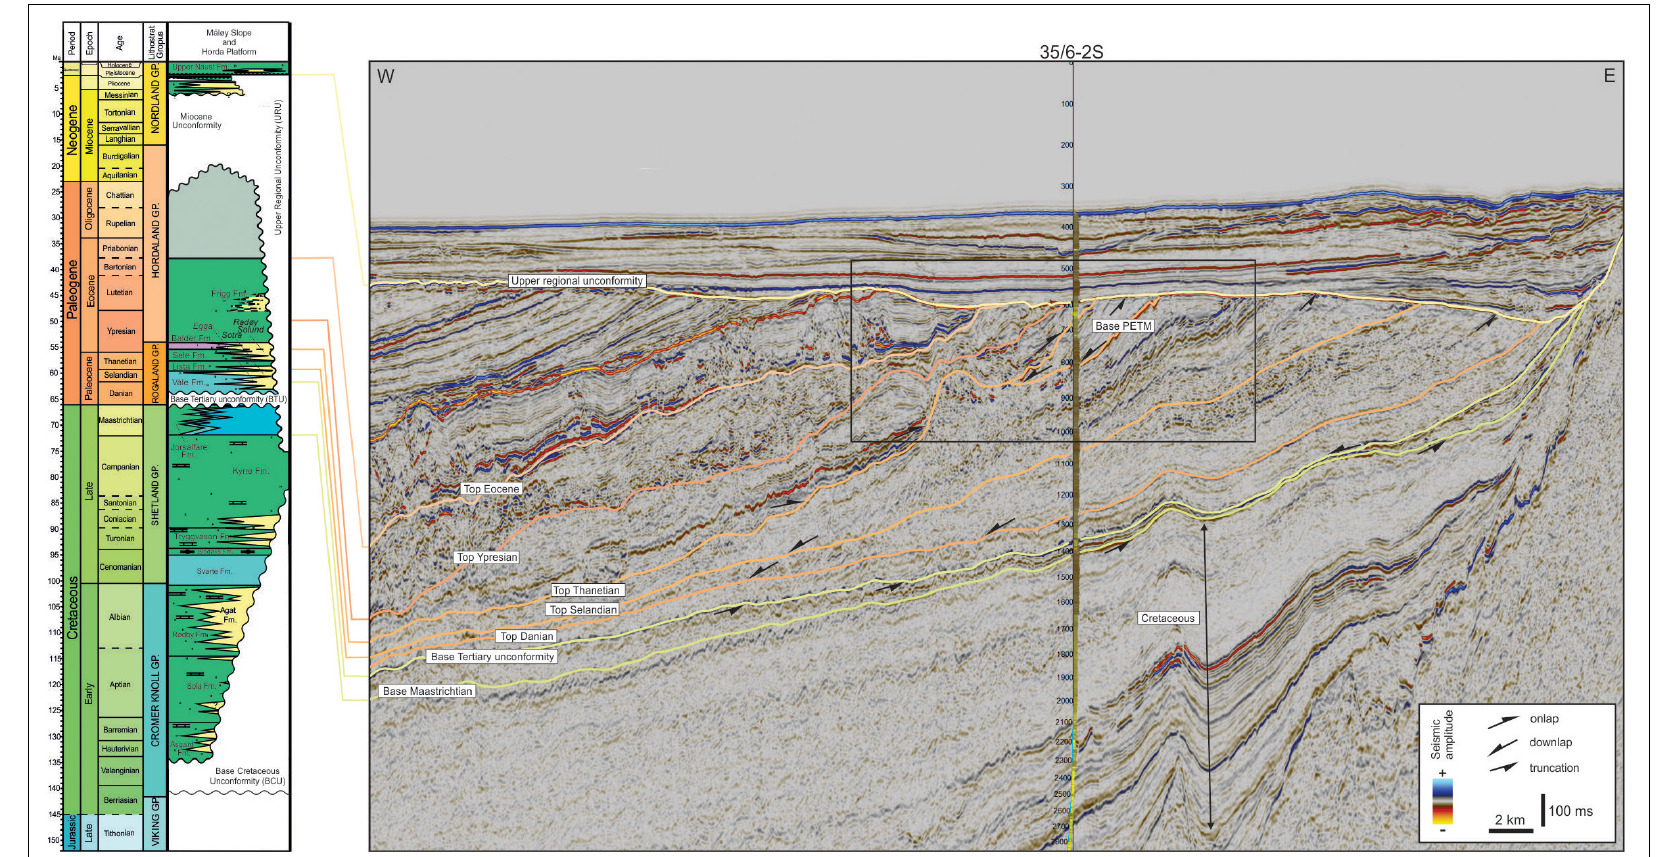
FIGURE 2 | Seismic dip-line and lithostratigraphic overview of key surfaces and units discussed in the text. Note the transition from basinward thickening wedge in the Cretaceous to basinward thinning wedge in the Paleocene. The line intersects borehole 35/6-2S which documents the Paleocene-Eocene Thermal Maximum (PETM). Black box shows the extent of Figure 5